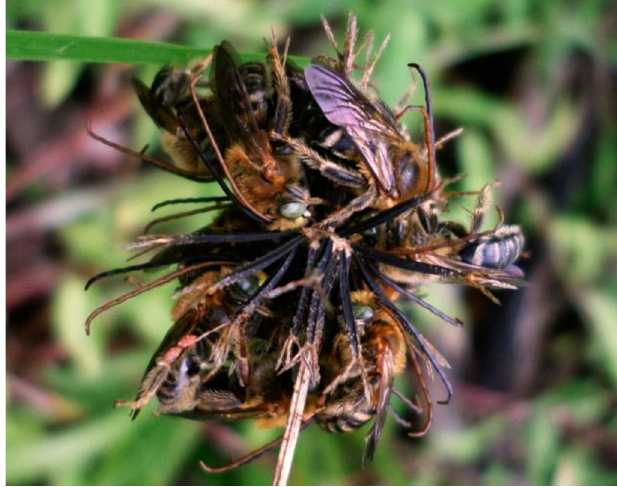
Fig 2. Melissodes nigroaenea males fixed in Bidens pilosa through the mandibles at the sleeping aggregation 40 cm above the